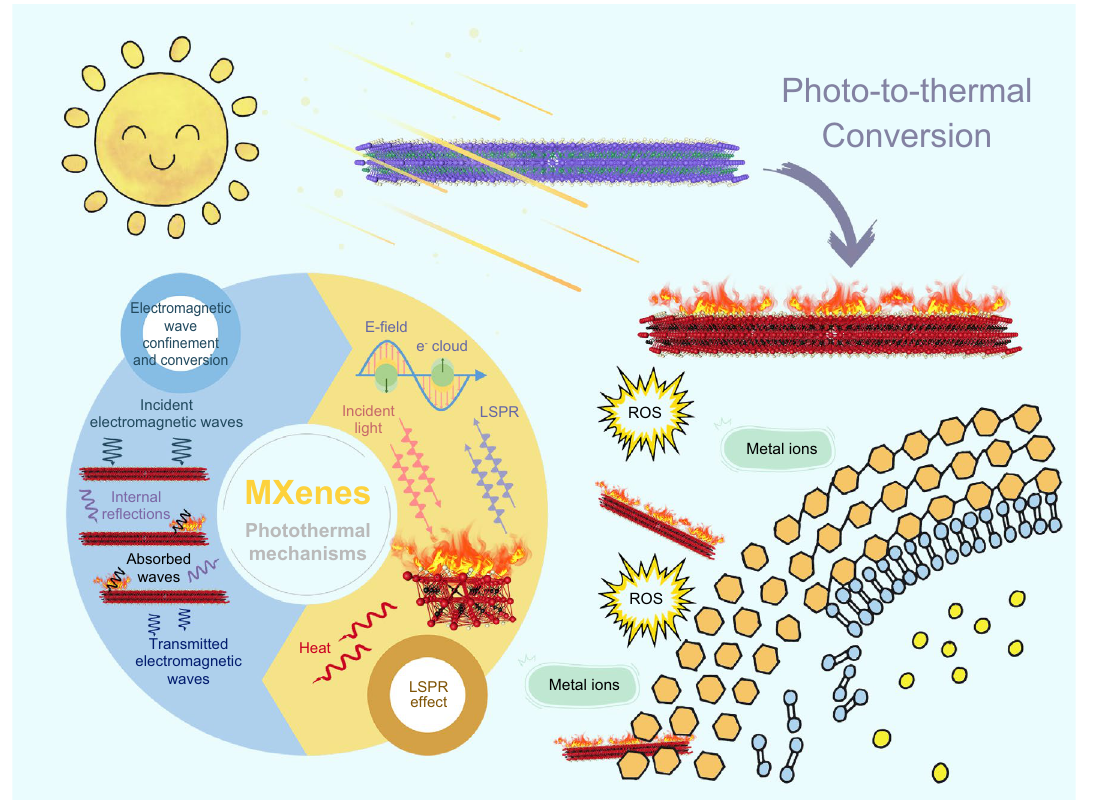
Fig. 5 The schematic photothermal mechanisms of MXenes account for superb photo-induced antimicrobial